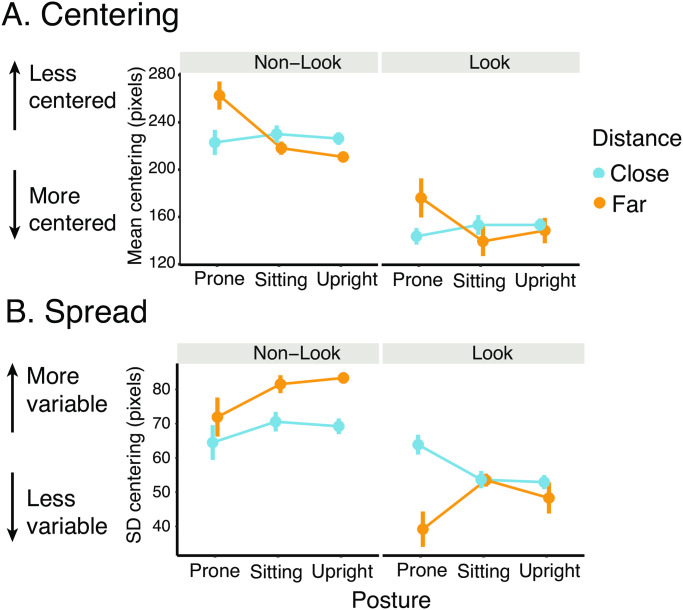
Centering and spread by posture, toy looking, and toy distance.(A) Centering and (B) spread of close toys (blue symbols) and far toys (orange symbols) during looking and non-looking episodes across postures. For centering, smaller values on the y-axis indicate better centering. For spread, smaller values on the y-axis indicate less variability of toy locations in the field of view.